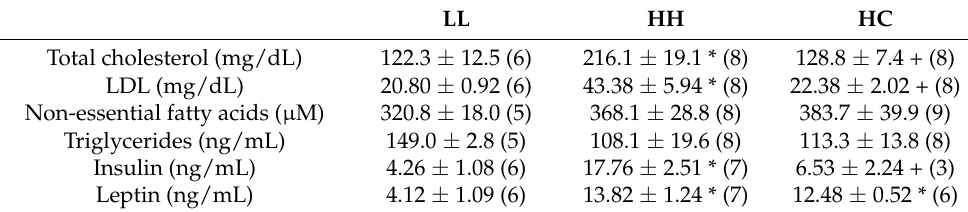
Figure 2. Intraperitoneal glucose and insulin tolerance test. ( A ) GTT; ( B ) GTT AUC; ( C ) ITT; and ( D ) ITT AUC in LL, HH, and HC mice. GTT, glucose tolerance test; AUC, area under the curve; ITT, insulin tolerance test; LL, offspring born from maternal LFLS and postnatal LFLS indicated by closed circles (●); HH, maternal HFHS and postnatal HFHS indicated by closed squares ( ■ ); HC, maternal HFHS weaned onto a standard laboratory chow diet indicated by a closed triangle ( ▲ ). Values are presented as mean ± SEM. Statistical significance is calculated by one-way ANOVA ( B , D ) or two-way ANOVA with post hoc Fisher’s LSD comparisons ( A , C ). * p < 0.05 and ** p < 0.01 vs. LL; † p < 0.05 vs. HH; ns, not significant. n = 6–12 in LL; n = 8–9 in HH; n = 11 in HC. Table 1. Plasma lipid biomarkers and